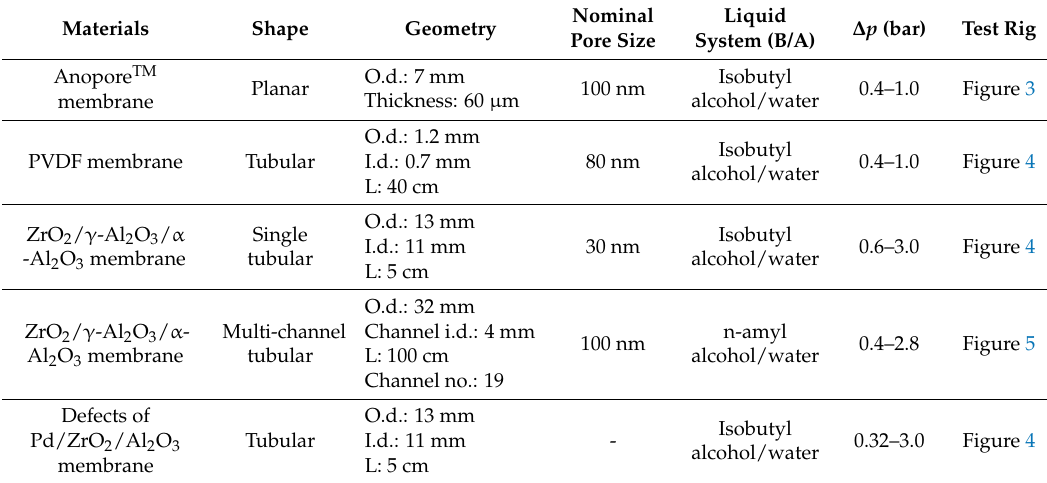
Geometrical details of materials investigated and operational characteristics during MLLDP